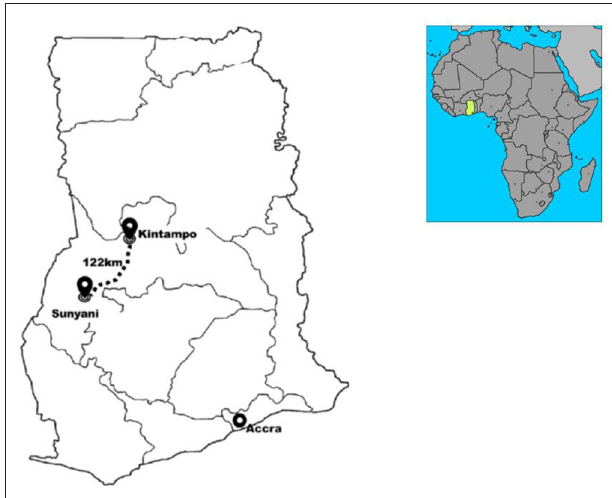
FIGURE 1 | Map of Ghana showing the two study sites, Sunyani and